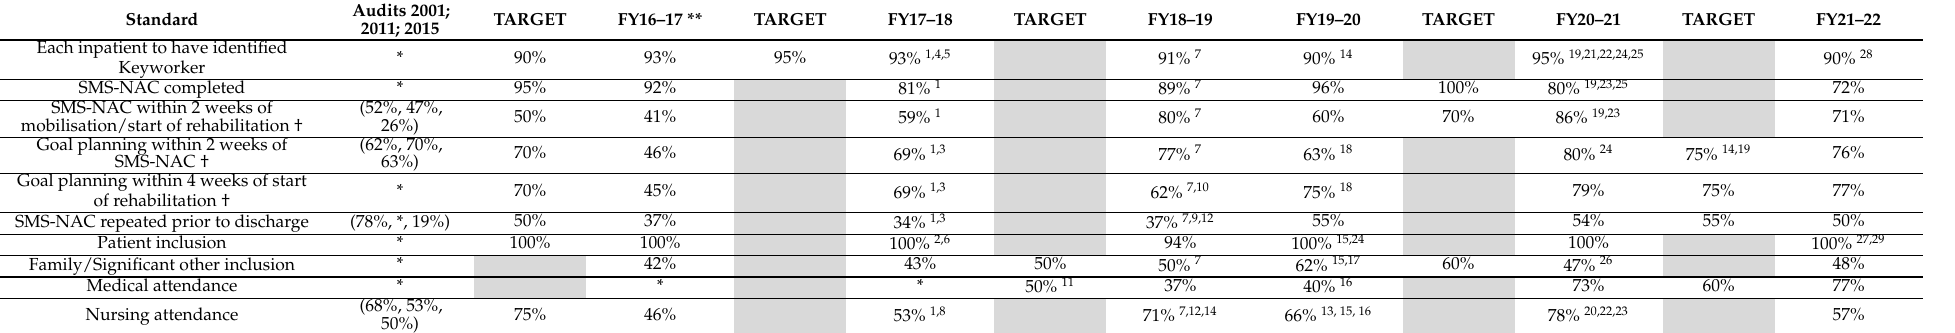
Table 6. Targets for the quality improvement project and interventions from